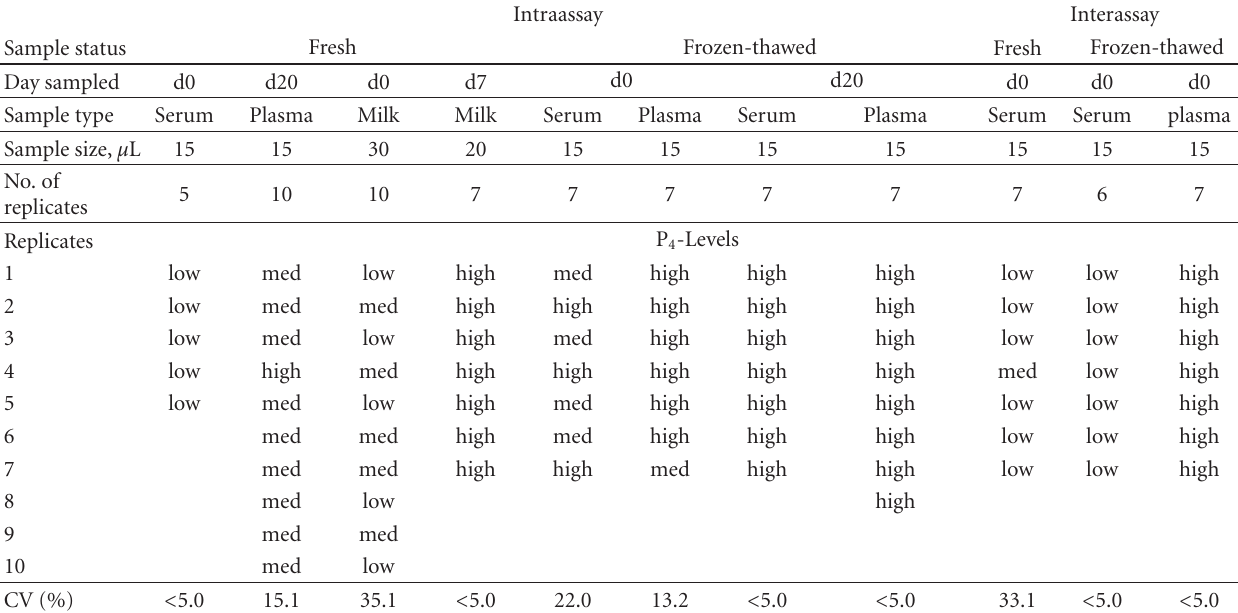
Table 1: Intra- and interassay measurements of relative P 4 concentrations [low (levels 1-2, < 3.0nM/L), medium (levels 3-4, 3.1–7.5 nM/L) or high (levels 5-6, > 7.6nM/L)), studied in fresh serum, plasma, or milk, or frozen-thawed serum or plasma samples, comparing di ff erent sample volumes, at various days (day 0, 7, or 20) of AI, provided by the eProCheck 800 . Number of observations per sample and coe ffi cient of variation (CV) are